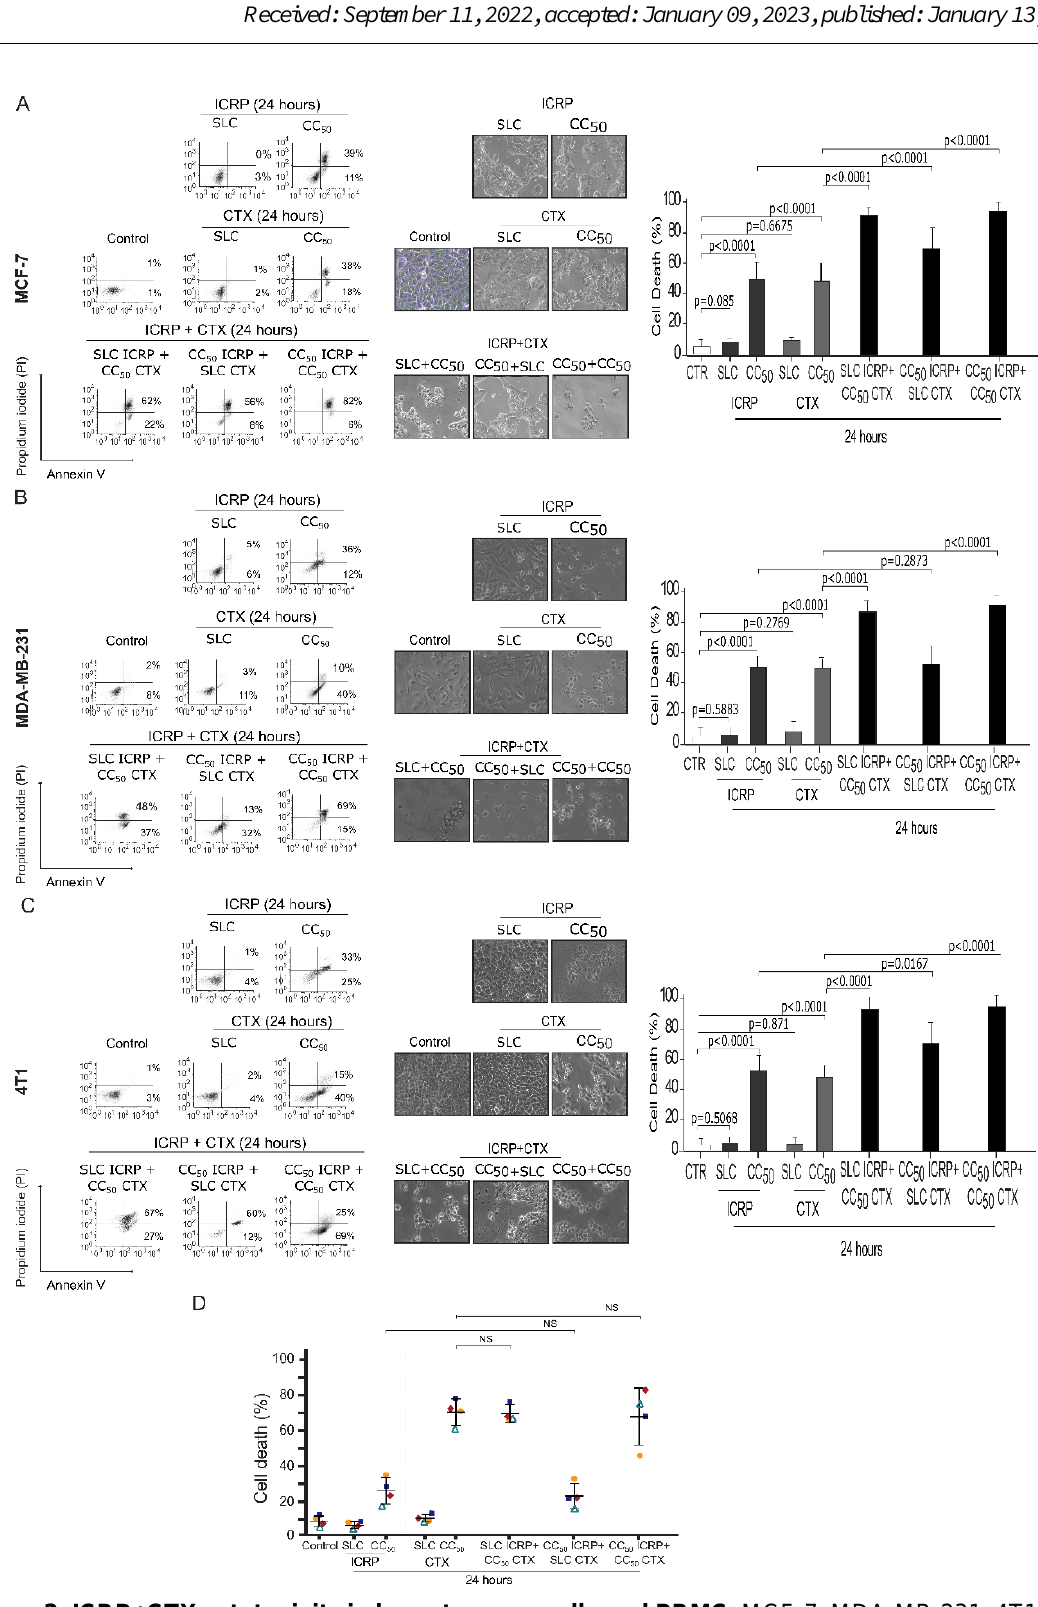
Figure 2: ICRP+CTX cytotoxicity in breast cancer cells and PBMC. MCF-7, MDA-MB-231, 4T1 cells and PBMC were treated for 24 h with ICRP, CTX and their combination at different ratios and analyzed by flow cytometry. AnnV/PI staining was used to analyze cell death of A ) MCF-7, B ) MDA-MB-231 and C ) 4T1 cells. Representative dot plots are shown on the left, representative images of morphological changes were taken in bright field using an inverted microscope (20X), and graphs are on the right. D ) Cell death of PBMC from healthy donors (n=4). Mean value of at least three independent experiments performed in triplicate ± SD were